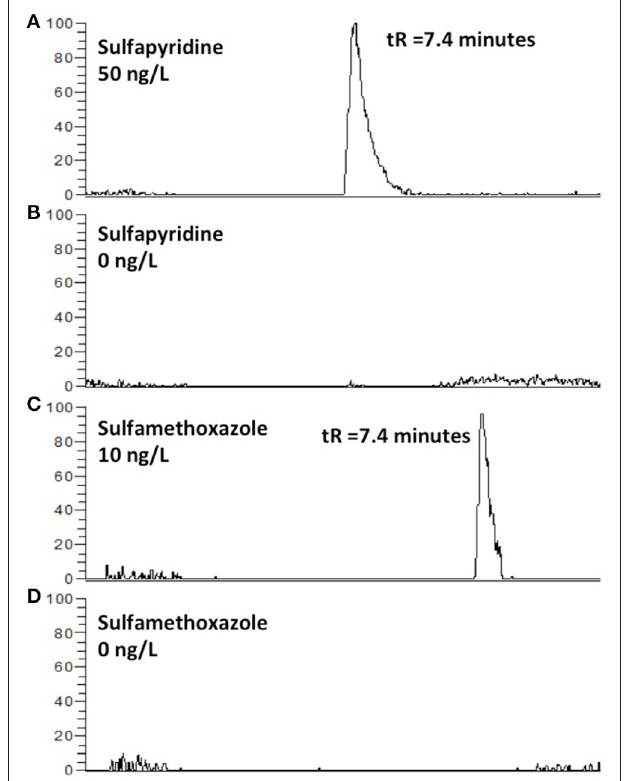
FIGURE 4 | EICC of sulfapyridine (A) , sulfametoxazole (C) followed by an injection of type 1 water (B,D) . Carry-over was not